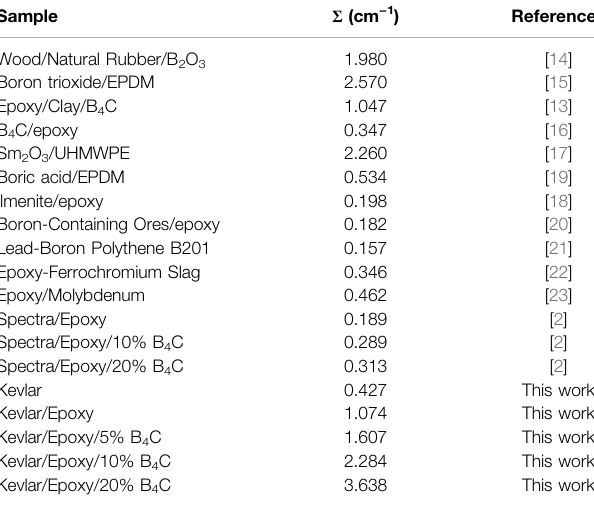
TABLE 1 | Σ data from this study as well as those from previous works.